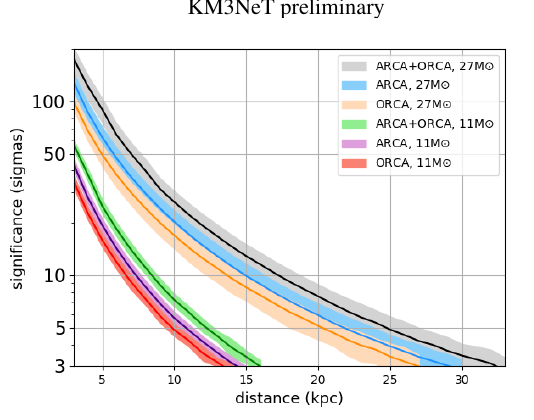
Figure 2. KM3NeT significance to a CCSN neutrino signal as a function of the distance to the